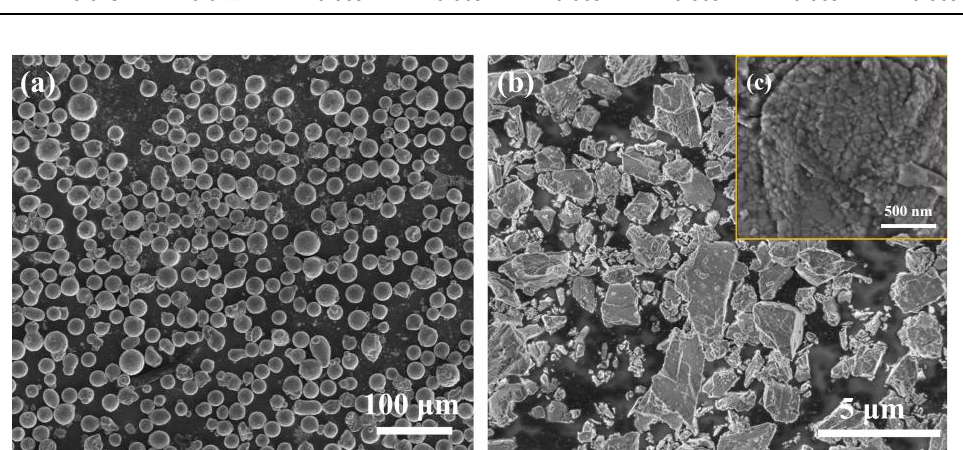
Table 1. Chemical composition of the AlSi10Mg powder (wt.%).